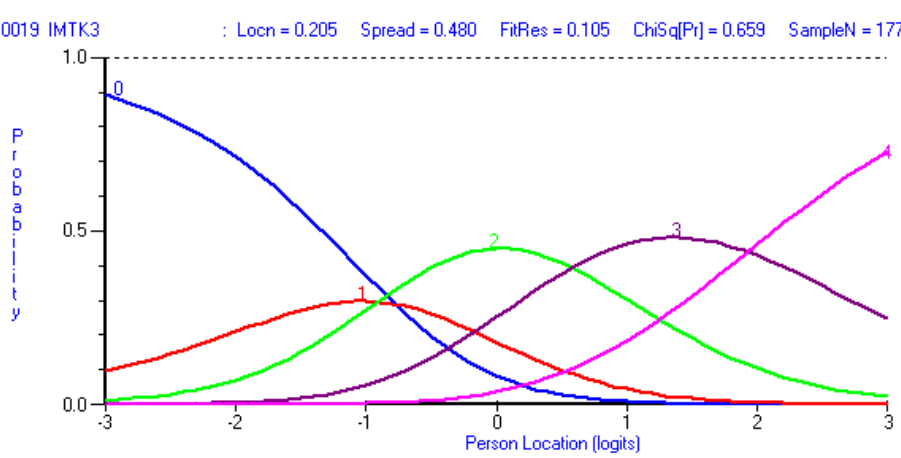
Figure A1. In this figure, evidence of a disordered threshold is presented in I0019 before scoring is adjusted. Category 1 (“corresponds a little”) never has maximal probability and would unlikely be selected by any respondent, regardless of person endorsability (i.e., logit). This suggests that the item categories are not functioning as intended.